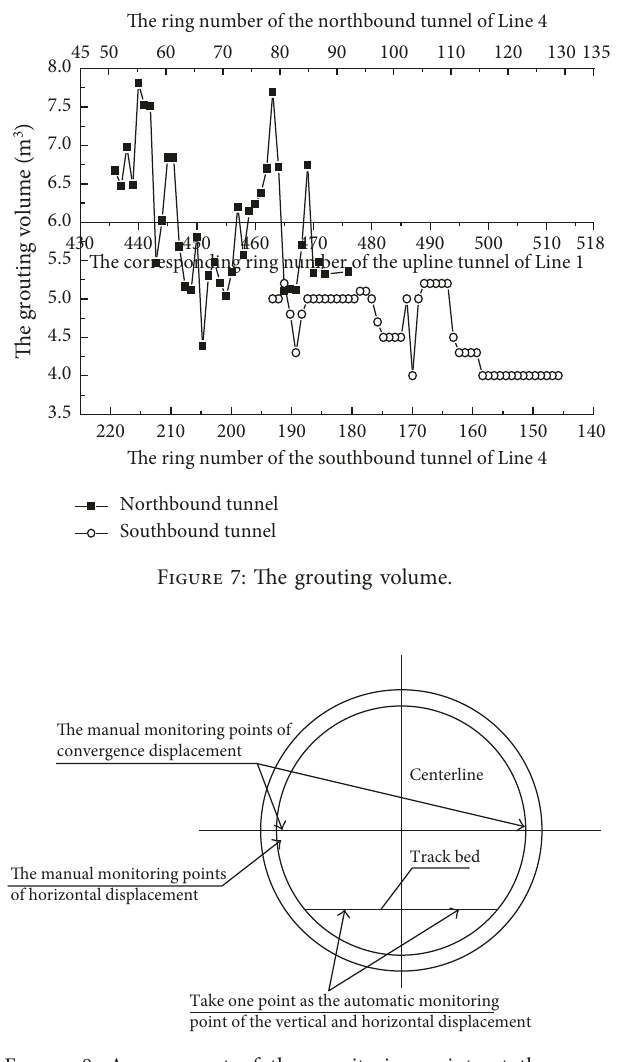
Figure 8: Arrangement of the monitoring points at the cross section of the existing tunnel.